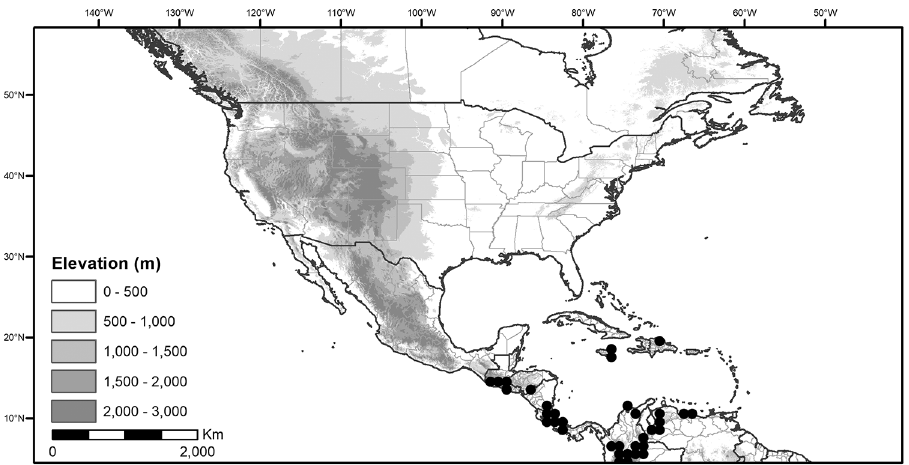
Figure 26. Distribution of Solanum macrotonum Bitter (points in northern South America included to show continuous